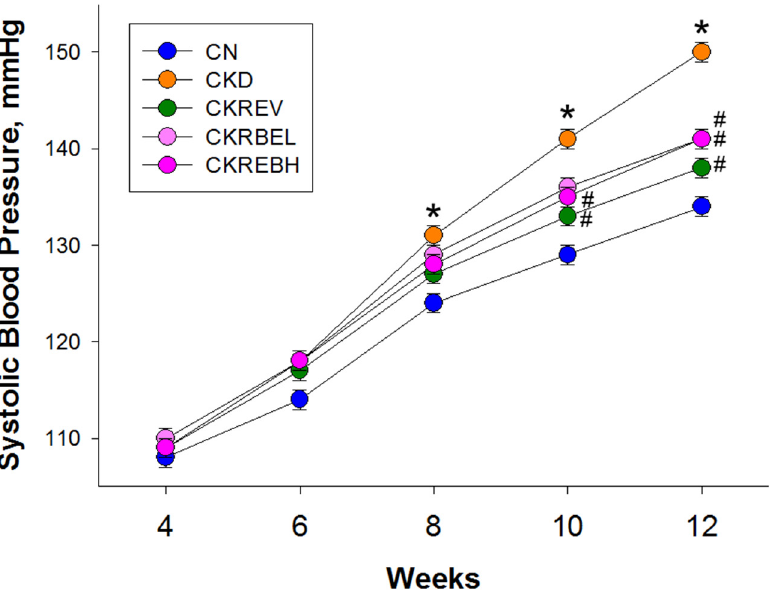
Figure 2. Effect of adenine-induced chronic kidney disease (CKD), resveratrol, or resveratrol butyrate ester on systolic blood pressure. N = 8/group; * p < 0.05 vs. CN; # p < 0.05 vs. CKD.